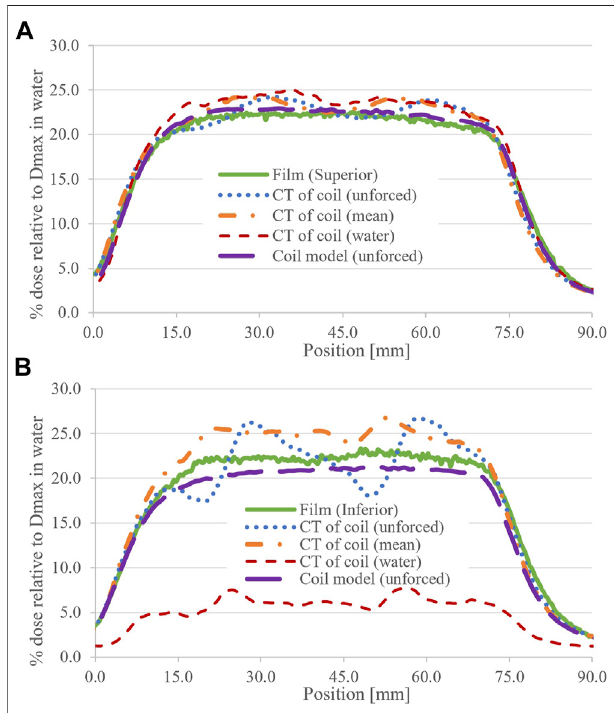
FIGURE 5 | Measured and calculated horizontal pro fi les for the 8.0 × 22.0 cm 2 fi eld for (A) superior and (B) inferior coil ends. The RED status of the coil structure (CT dataset) and the air (coil model) is shown in